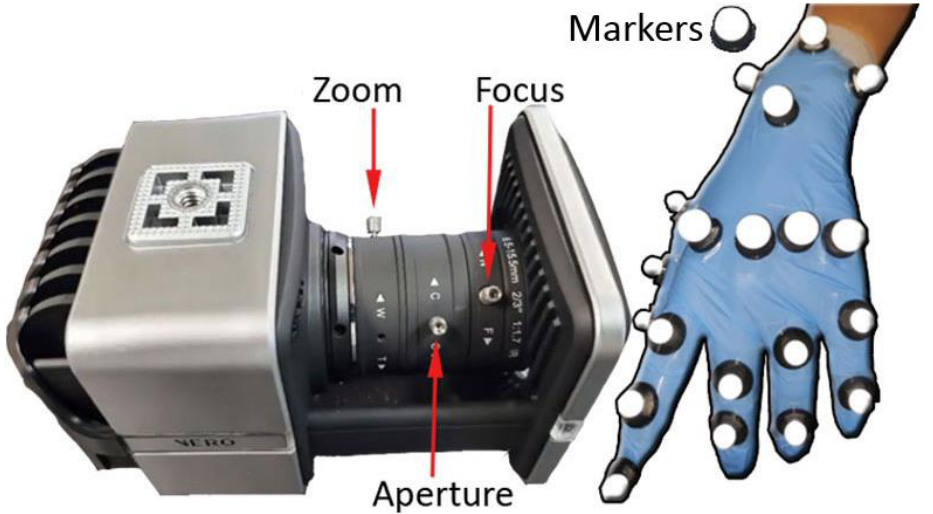
Figure 3. Main functionalities of Vero Vicon and example of distribution of markers in the hand.